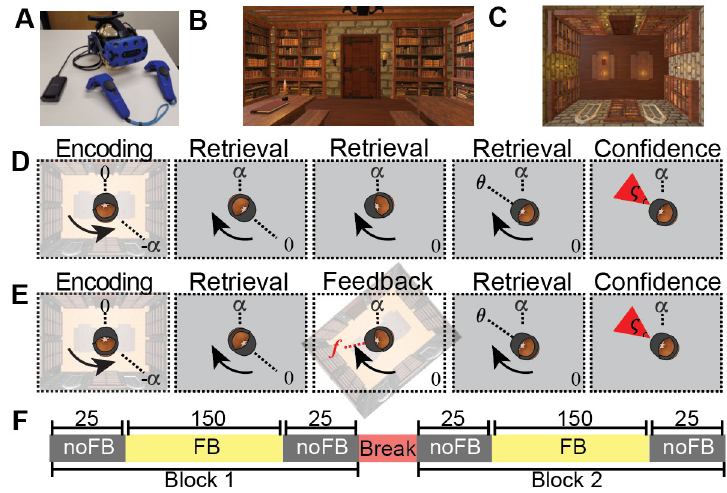
Fig 1. Task procedure. (A) Participants wear an HTC VIVE headset along with the handheld controllers to immerse themselves in a virtual room (B, C). First person view of the virtual environment at the beginning of a trial. (C) Top down view of the virtual environment. (D, E) Trial timeline for No Feedback (D) and Feedback (E) trials. At the start of each trial they face the door of the room and turn through − α degrees with visual feedback present. Visual feedback is then removed (gray squares) and they must turn back α degrees to face the door again. At the end of the turn participants stop at heading angle θ t and report their confidence B by adjusting the size of a red rectangle. The only difference between the No Feedback and Feedback conditions is the presence of a brief flash of visual information part way through the turn in the Feedback condition (E). Overall participants completed 300 trials of the Feedback condition and 100 trials of the No Feedback condition over the course of the experiment (F).